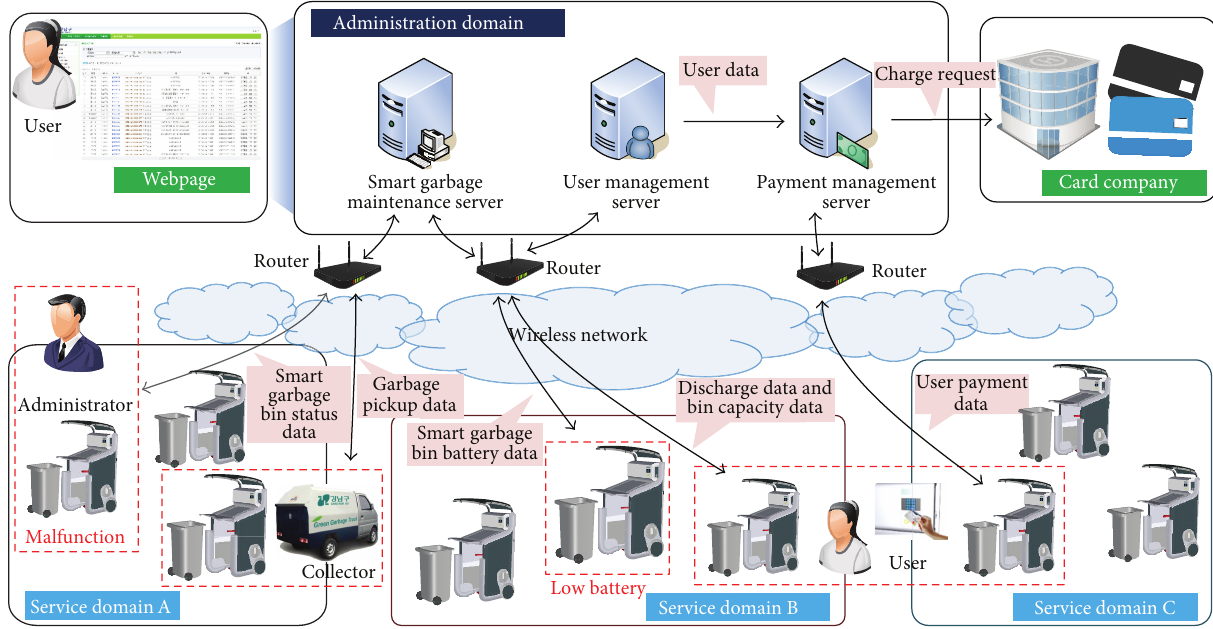
Figure 1: Overview of smart garbage system.